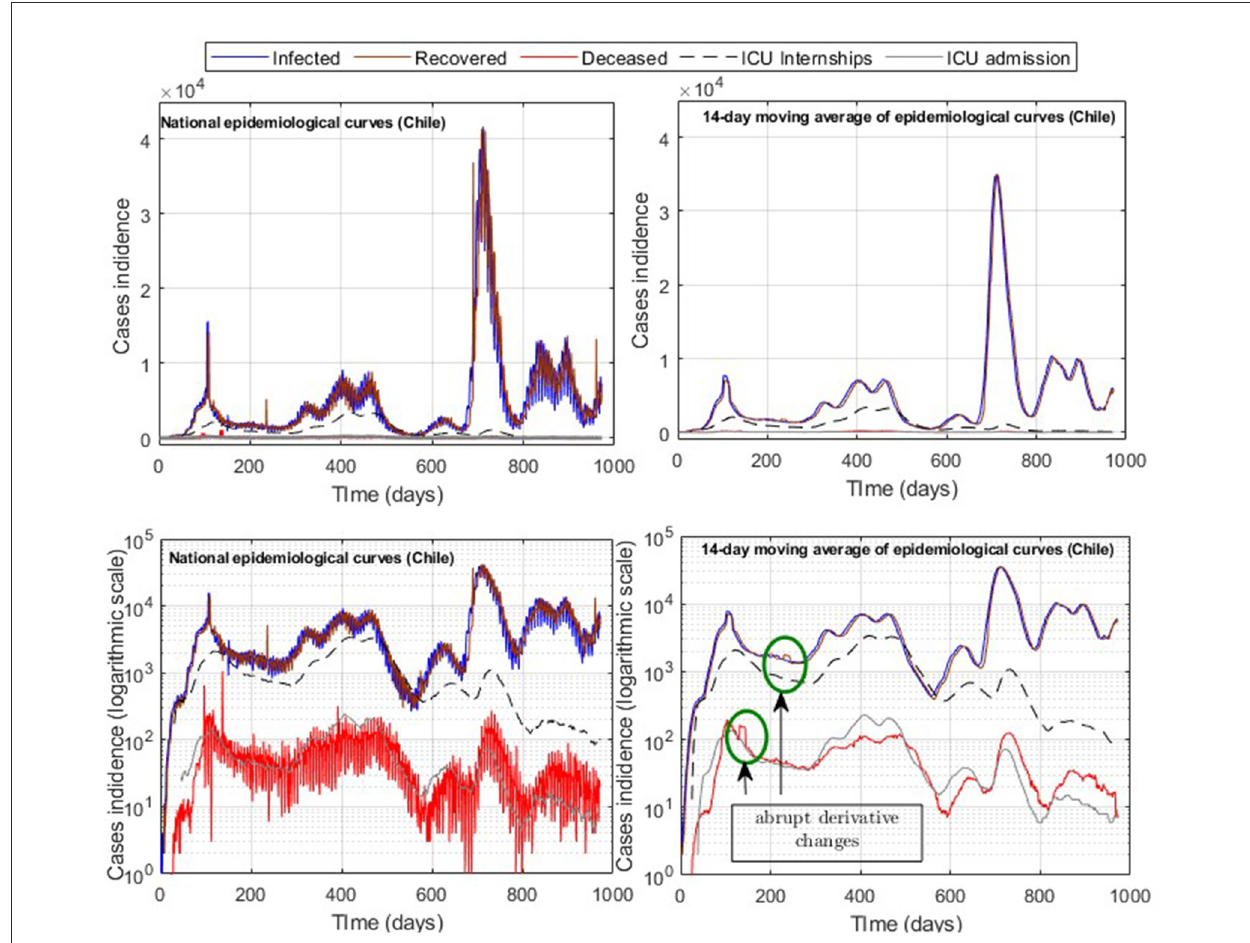
FIGURE1 Official COVID-19 incidence curves (Chile); raw data and processing with moving